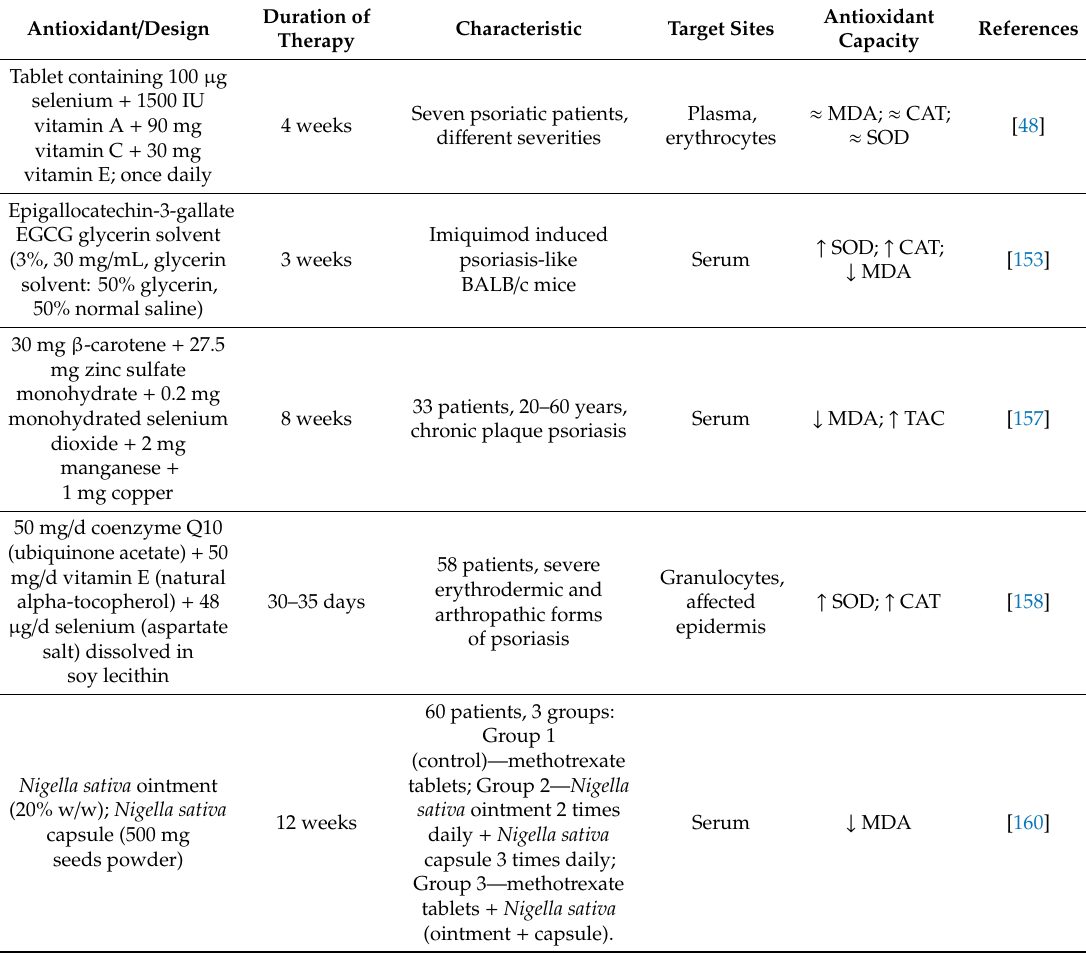
Table 2. Protective e ff ects of dietary antioxidants on the antioxidative status in patients with psoriasis. Antioxidant /